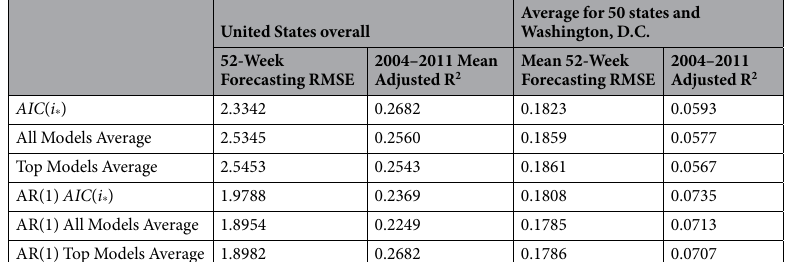
Table 3. Modeling results for each method described by the 52-week forecasting RMSE and adjusted R 2 values for the U.S. overall and the average for 51 U.S. regions. Abbreviations: AIC ( i Models Average: average of 2 n − 1 models using posterior probabilities, Top Models Average: average of few most probable models using posterior probabilities, AR(1): models using the simple AR(1) Cochrane-Orcutt correction, RMSE: root-mean-square